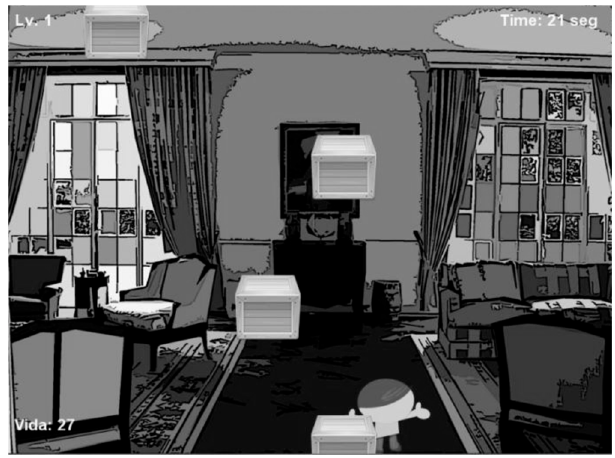
Figure 1. The computer game Fallbox. The avatar must dodge the falling boxes.